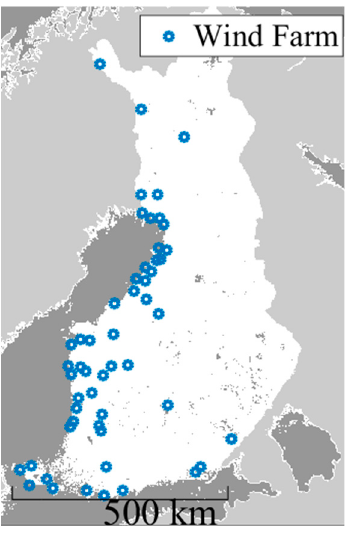
Figure 7. The operational wind farms in Finland at the end of 2015. Individual wind turbines less than 15 km apart are aggregated as a single generation location (wind farm) in the map.